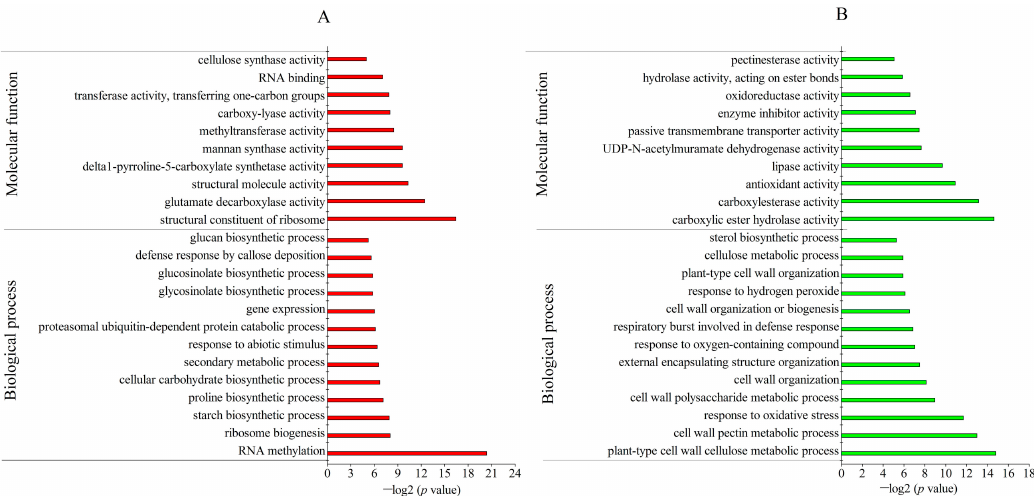
Figure 4. Gene ontology (GO) enrichment analysis of up- and down-accumulated DAPs between 7RTR and 7RCK. ( A ) Up-accumulated proteins. ( B ) Down-accumulated proteins.